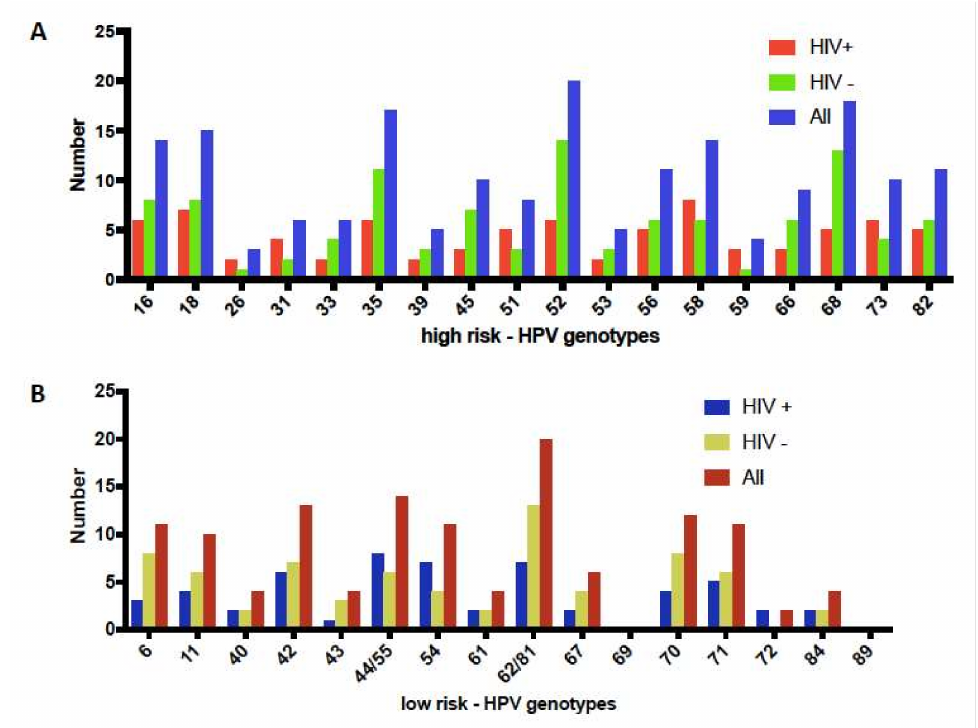
Figure 1. Number of women with each high-risk HPV genotypes ( A ) and low-risk genotypes ( B ) according to HIV status in the overall